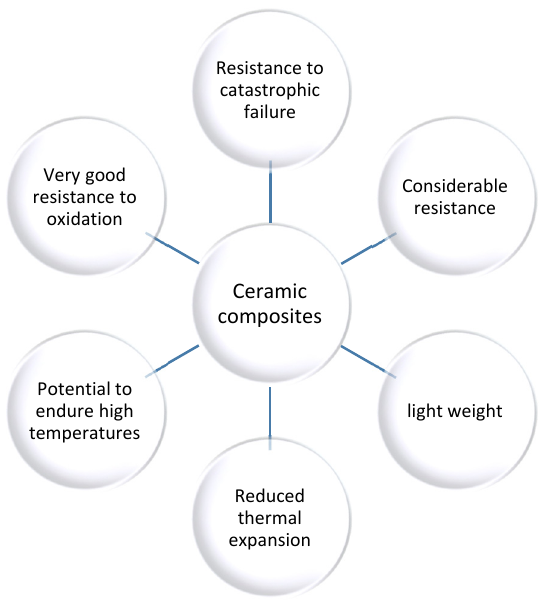
Figure 1. Properties of ceramic composites [18].